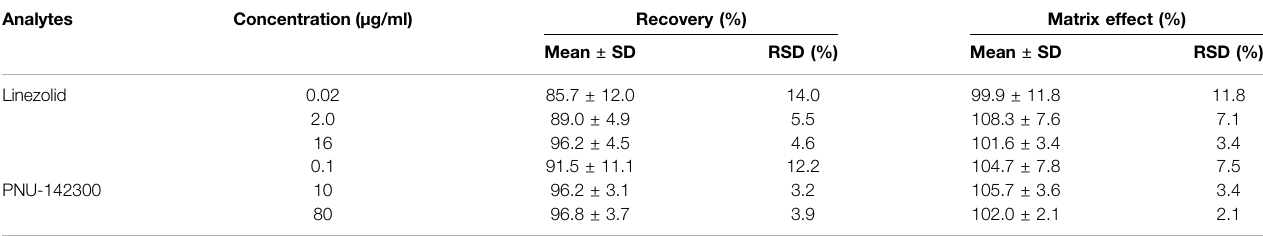
TABLE 3 | Stability results of linezolid and PNU-142300 in serum under different conditions ( n (cid:2) 5). Analyte